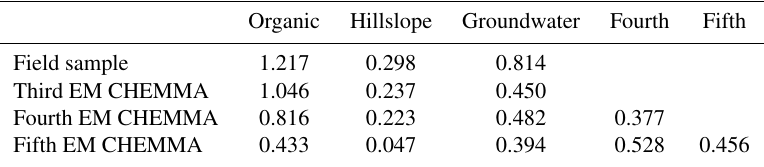
Table 3. End-member distance from observational plane to Principal Component subspace.